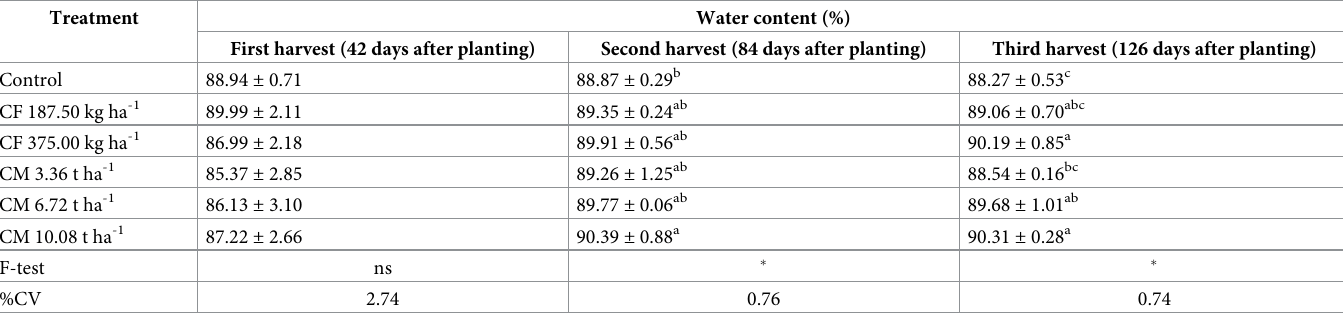
Data represent mean values ± standard deviation (SD). Mean with different letters in the same column indicate a significant difference according to Duncan’s multiple range test at p < 0.05. ns, � Non-significant or significant at p < 0.05,